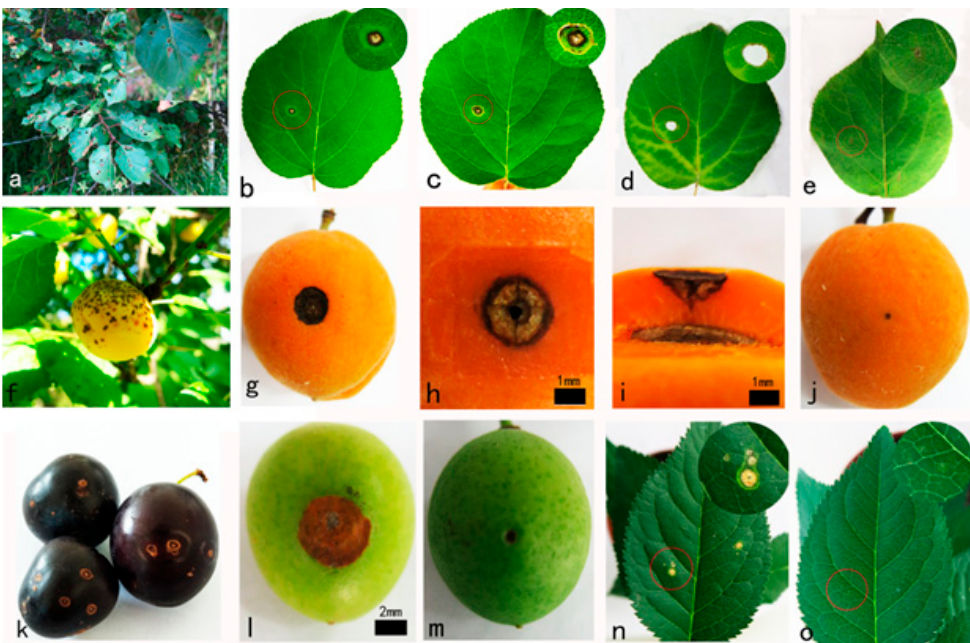
Figure 1. Symptoms in the field and inoculated W. carpophilus fungus symptom development during pathogenicity tests on Prunus armeniaca and Prunus divaricate : ( a ) natural disease symptoms on P. armeniaca leaves growing in the field; ( b – d ) inoculation on P. armeniaca leaves (3, 9, and 17 d); ( e ) P. armeniaca leaf control; ( f ) natural disease symptoms on P. armeniaca fruits growing in the field; ( g–i ) inoculation on P. armeniaca fruits for 12 d (h: transverse section through lesion; i: longitudinal section through lesion); ( j ) P. armeniaca fruit control; ( k ) natural disease symptoms on P. divaricata fruits growing in the field; ( l ) inoculation on P. divaricata fruits for 6 d; ( n ) inoculation on P. divaricata leaves for 10 d; ( m,o ) control with P. divaricata fruits and leaves. Scale bars: h, i = 1 mm; l = 2 mm. A total of 800 fruits from 20 P. divaricata trees were surveyed in Huocheng County, with